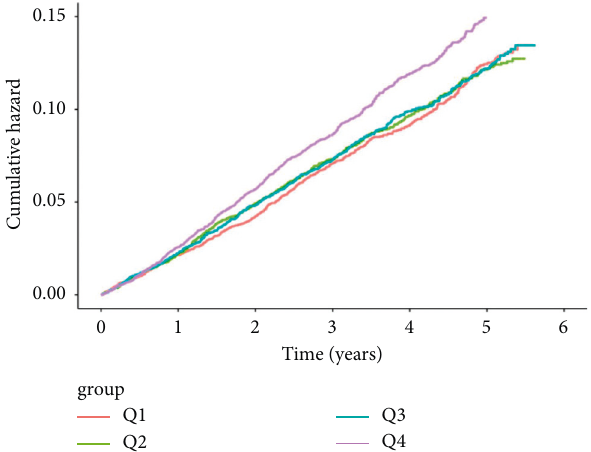
Figure 2: Cumulative incidence curves for the CVD events according to the quartiles of TyG